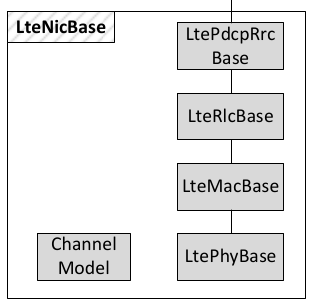
eNodeBBinder Figure 3. System overview of the radio-access network (grey: INET modules; white: SimuLTE modules). The NIC modules in both the UE and eNB nodes implement the functionalities of the four layers of the LTE protocol stack, namely PDCP, RLC, MAC and PHY. For this reason, we modeled the LteNicBase module shown in Figure 4, which is composed of four submodules having a one-to-one correspondence with the LTE protocols. Another module, namely the ChannelModel, is introduced to simulate the effects of air transmissions, as we will explain in the next subsection. According to the OMNeT++ paradigm, each submodule is composed by a NED file and a C++ class defining, respectively, its structure and behavior. However, the same layer might perform different operations at the UE and at the eNB. For example, the MAC layer at the eNB carries out the resource scheduling,